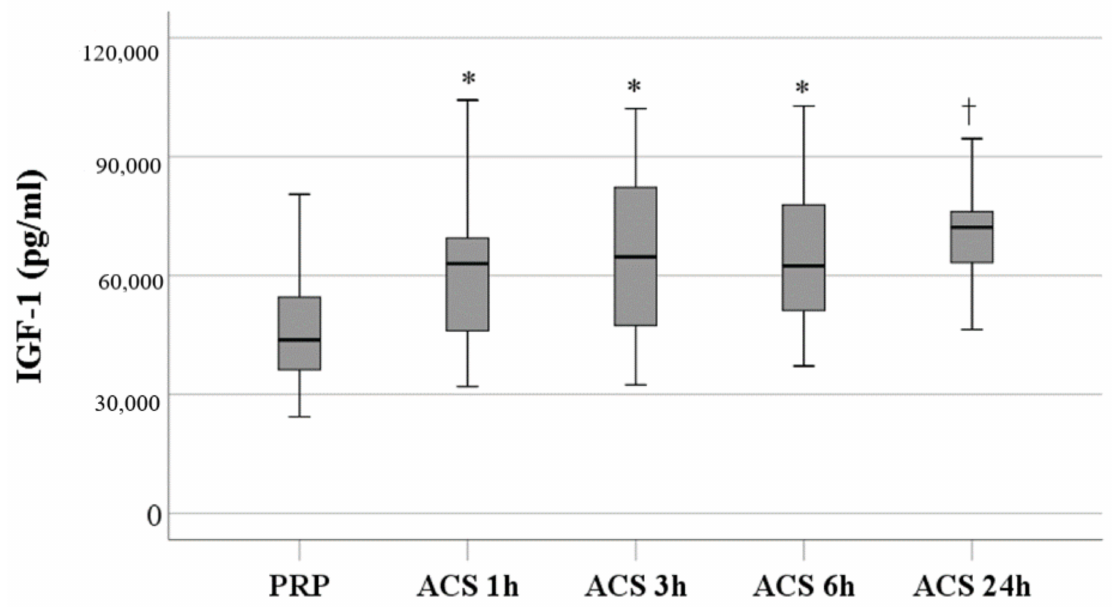
Figure 3. Insulin-like growth factor (IGF)-1 levels of platelet-rich plasma (PRP) and autologous conditioned serum (ACS) with different incubation times. * indicates a significant difference as compared to PRP; † indicates a significant difference as compared to PRP and ACS 1 h.